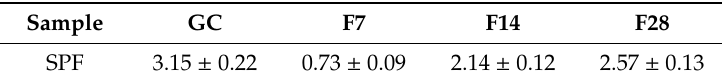
Table 4. Ability of green co ff ee to protect against UV